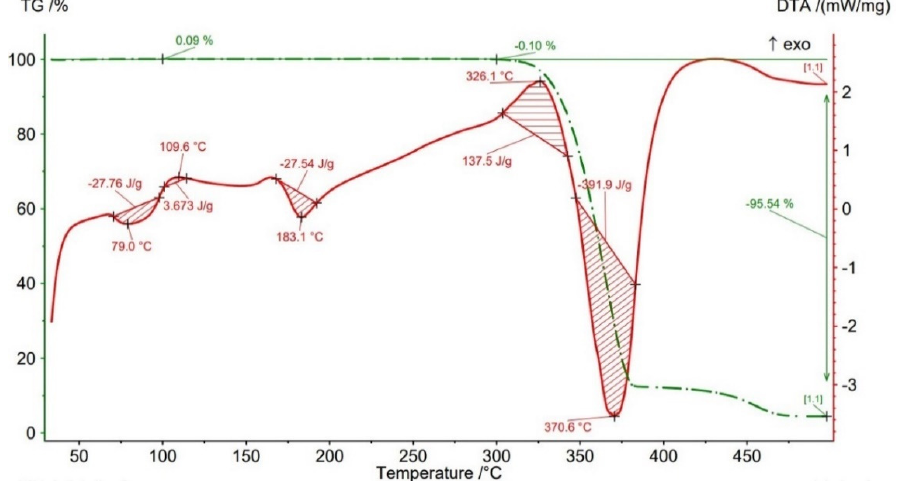
Figure 13. TGA results for sample with 25% infill density.